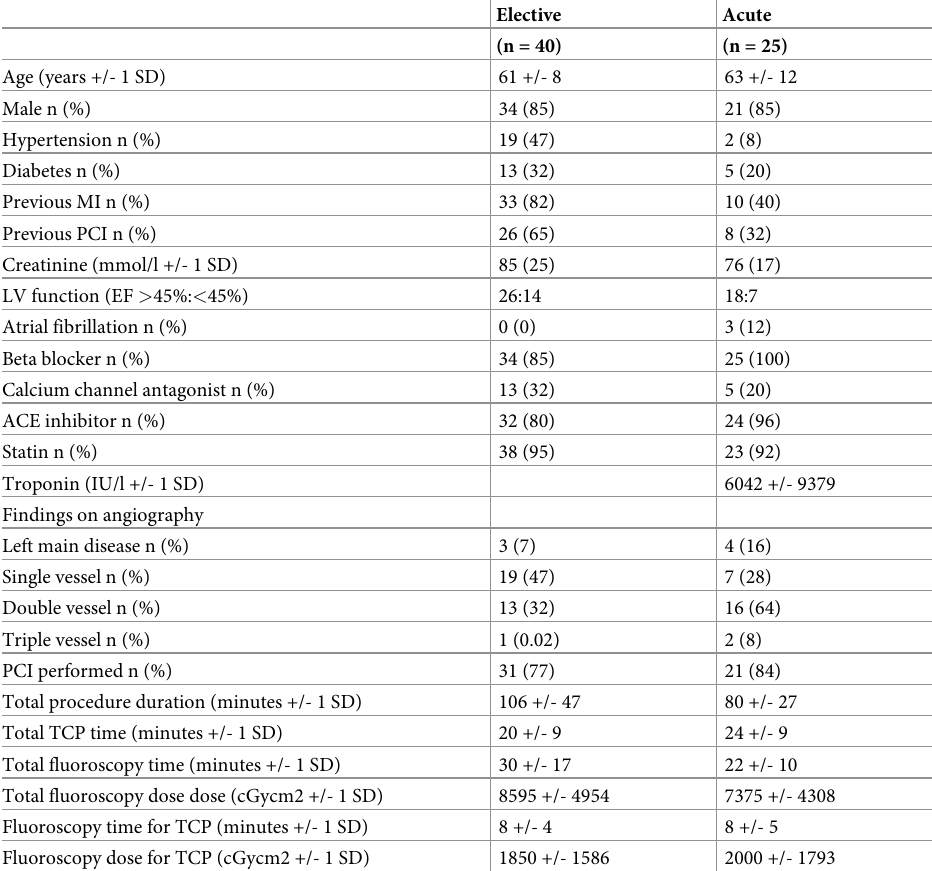
Table 1. Baseline parameters and angiography details for elective and acute trial participants. Elective